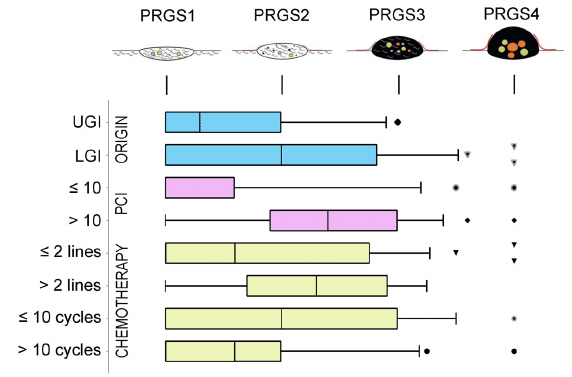
Figure 2: Sensitivity analysis of histological regression (PRGS) of peritoneal cancer after systemic chemotherapy.